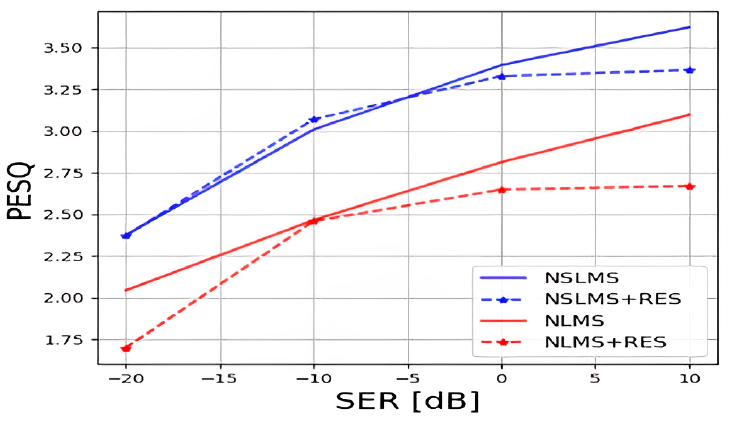
Figure 6. PESQ in double-talk-only scenarios for different SERs.